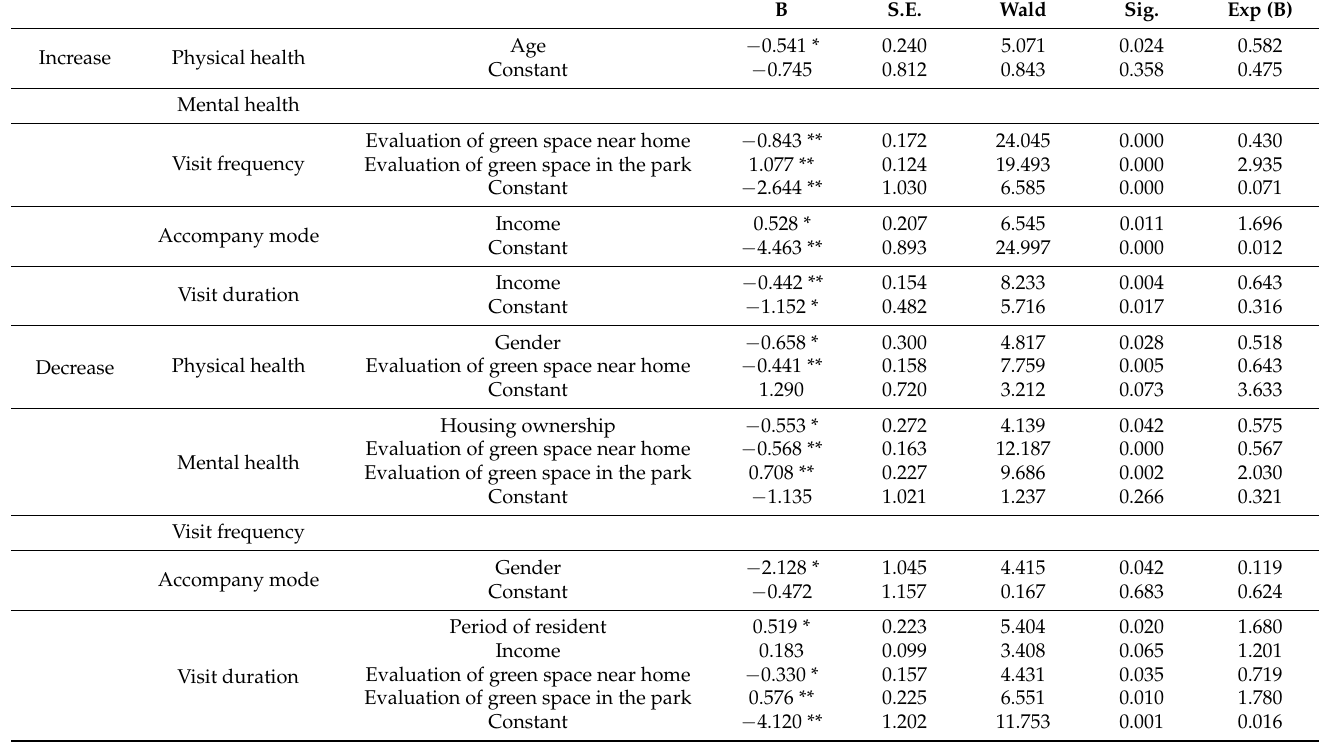
Table 6. The relationship between increasing and decreasing trends and some independent variables. B S.E. Wald